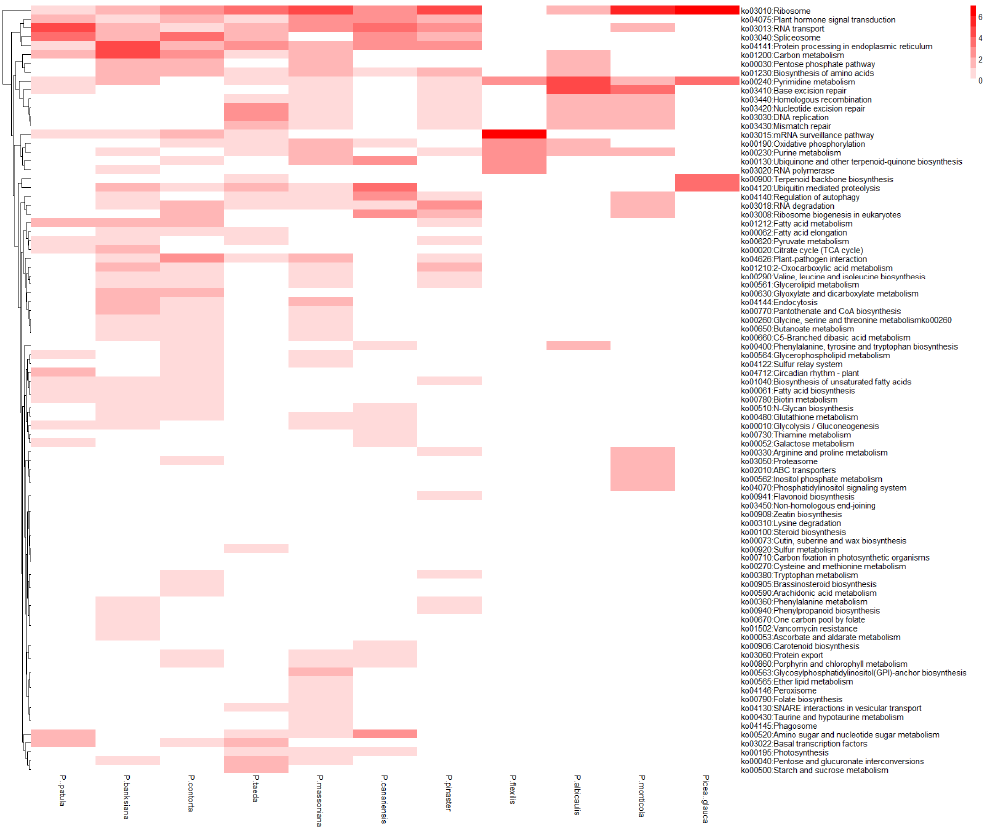
Figure 6. The heatmap representing the number of positive selection genes annotated to the Kyoto Encyclopedia of Genes and Genomes (KEGG) pathway. The colors from white (0) to red (8) represent the number.